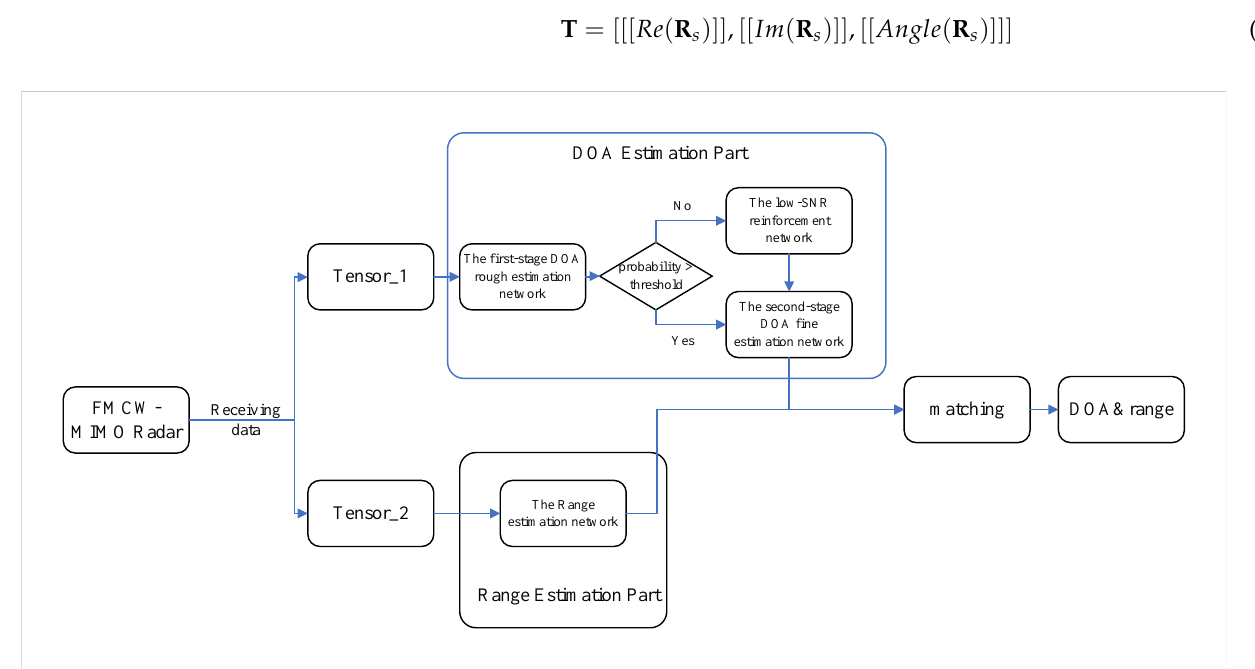
Figure 3. The complete estimation process of